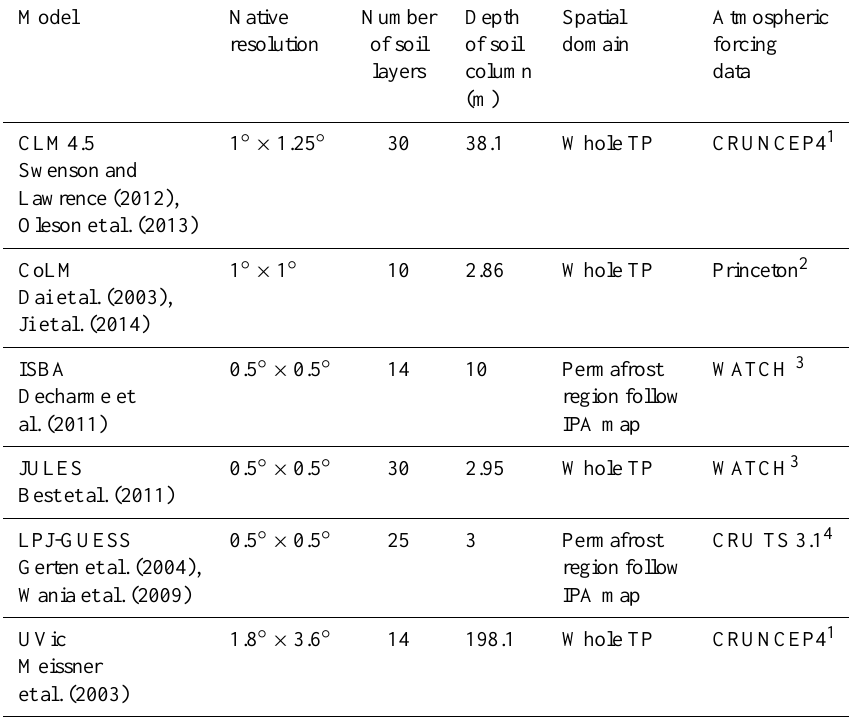
Table 1. The six land-surface models, analyzed over the Tibetan plateau (TP). Model Native